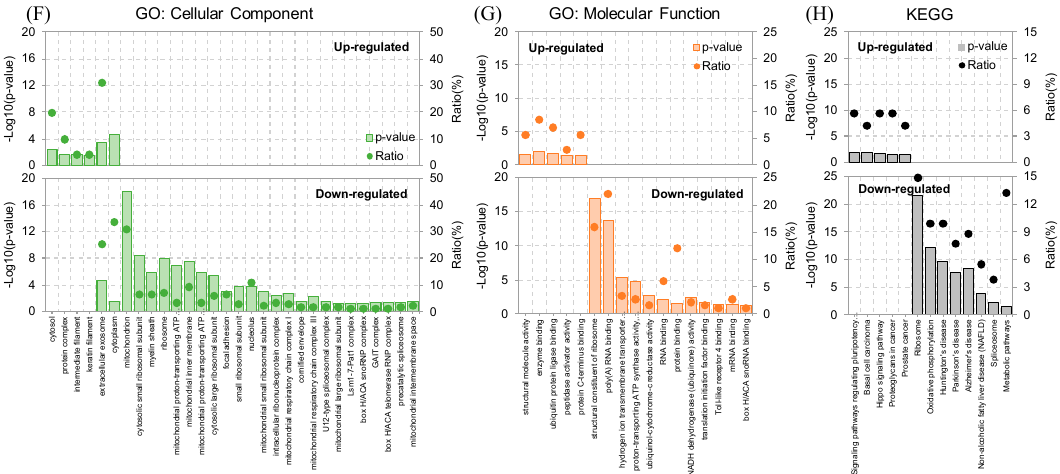
Figure 3. Functional enrichment analysis of up- and down-regulated di ff erentially expressed genes (DEGs) in the striatum ( A – D ) and whisker follicle ( E – H ). Gene Ontology (GO) and Kyoto Encyclopedia of Genes and Genomes (KEGG) pathway were analyzed in up- and down-regulated di ff erentially expressed genes (DEGs) using Database for Annotation, Visualization, and Integrated Discovery (DAVID) database. The horizontal axis represents various functional terms, including biological process (BC) ( A , E ), cellular component (CC) ( B , F ), molecular function (MF) ( C , G ), and KEGG pathway ( D , H ). The vertical axis represents the p -value ( − Log10) and ratio (%) of the number genes enriched in GO and KEGG